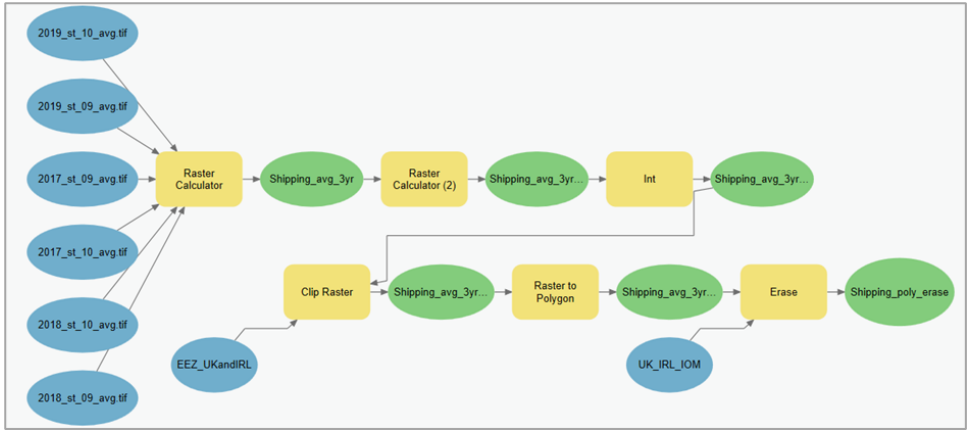
Figure 4. The model developed in ArcGIS Pro to process the AIS data for general cargo ships.